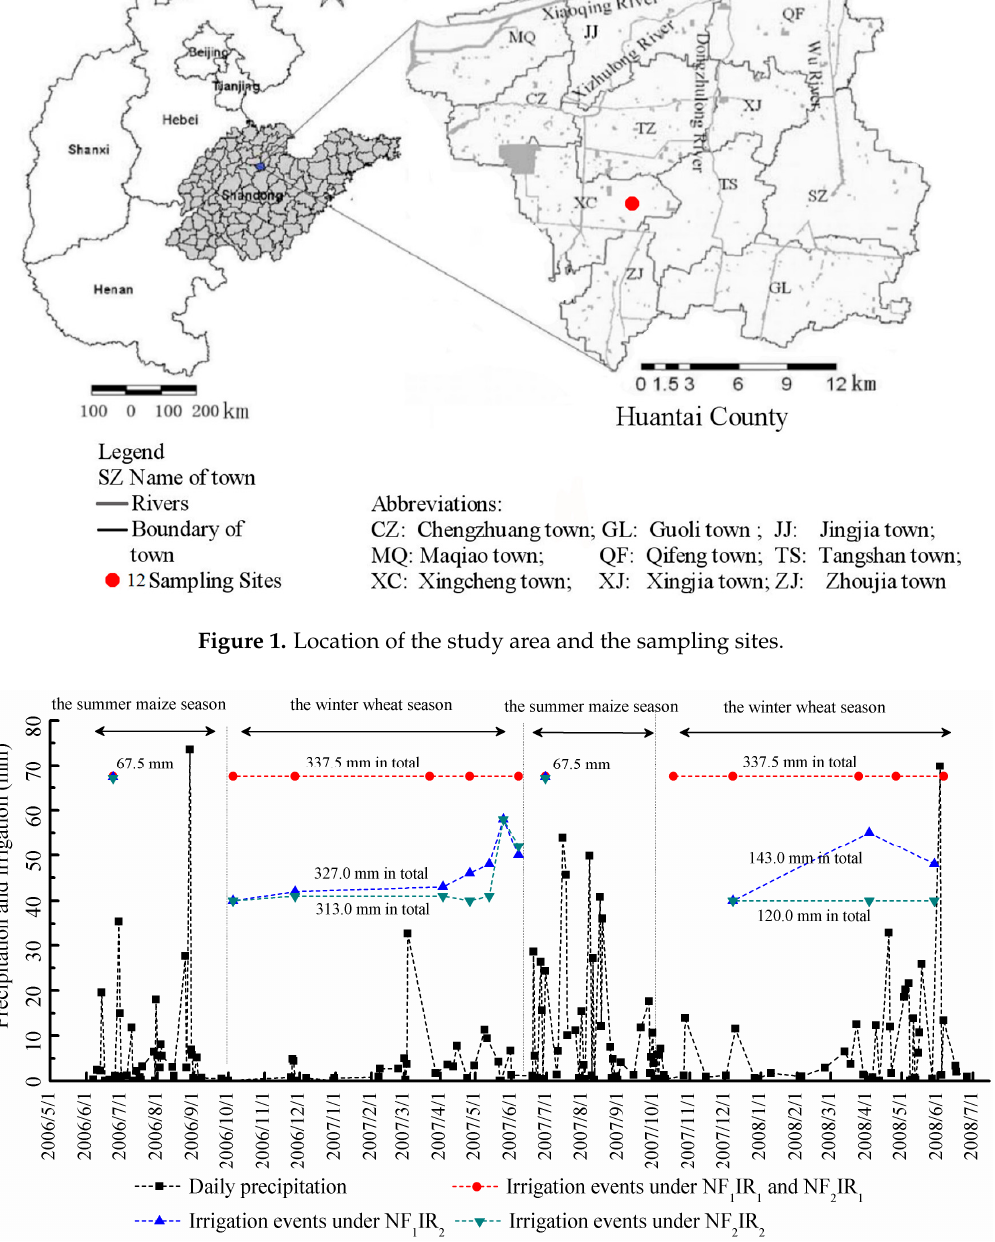
Figure 2. Daily rainfall and irrigation events from June 2005 to May 2008 in Huantai County.